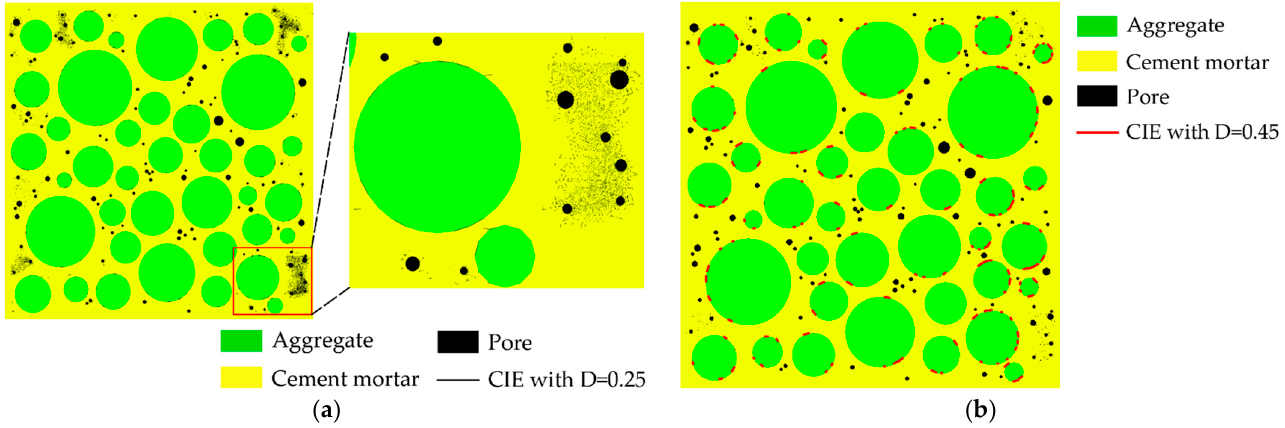
Figure 11. The distribution of CIEs with D = 0.25 and D = 0.45 when σ / σ max ≈ 0.36 in the 1-1-S specimen. ( a ) D = 0.25; ( b ) D = 0.45.